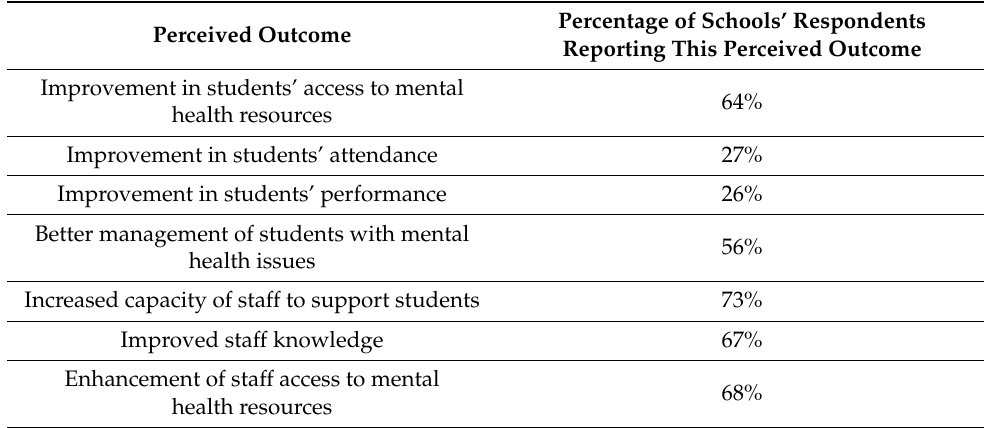
Table 2. Perceived outcomes of the Ed-LinQ initiative on students and staff outcomes among schools that were at least aware of the initiative ( n =